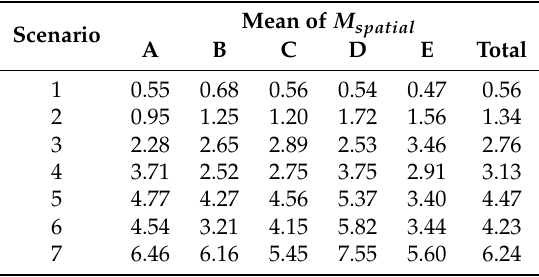
Table 2. Numerical results are shown for each target. The results for the M spatial indicator are summarized (no unit).